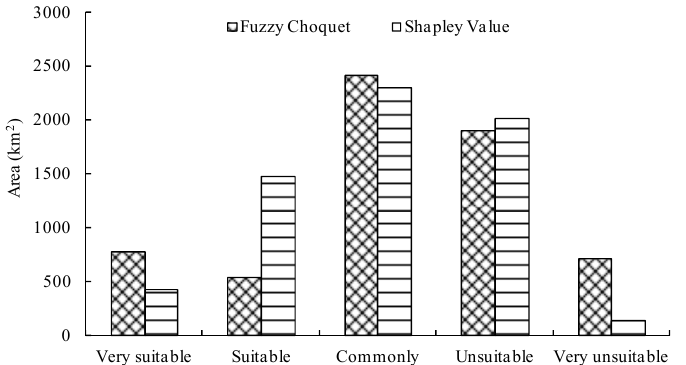
Figure 6. The area of wind farm alternative comparison between Choquet fuzzy integral method and Sharpley value. Table 4. The area of the same category by Choquet fuzzy integral method and Sharpley value (km 2 ).